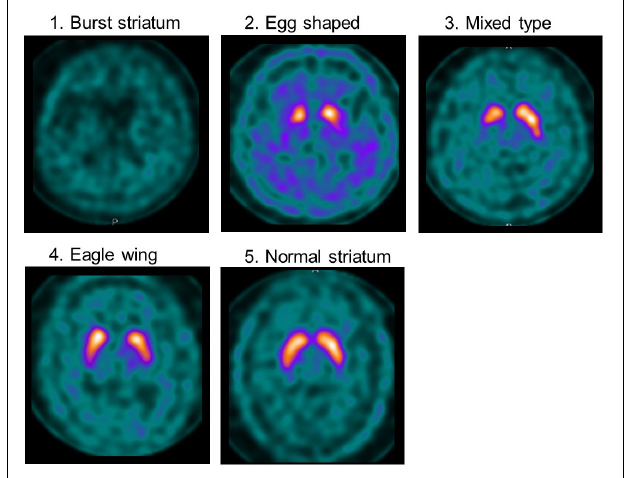
FIGURE 1 | Examples of visual assessment using 123I-Ioflupane SPECT. Grade 1 (burst striatum): severe bilateral reduction with almost no uptake